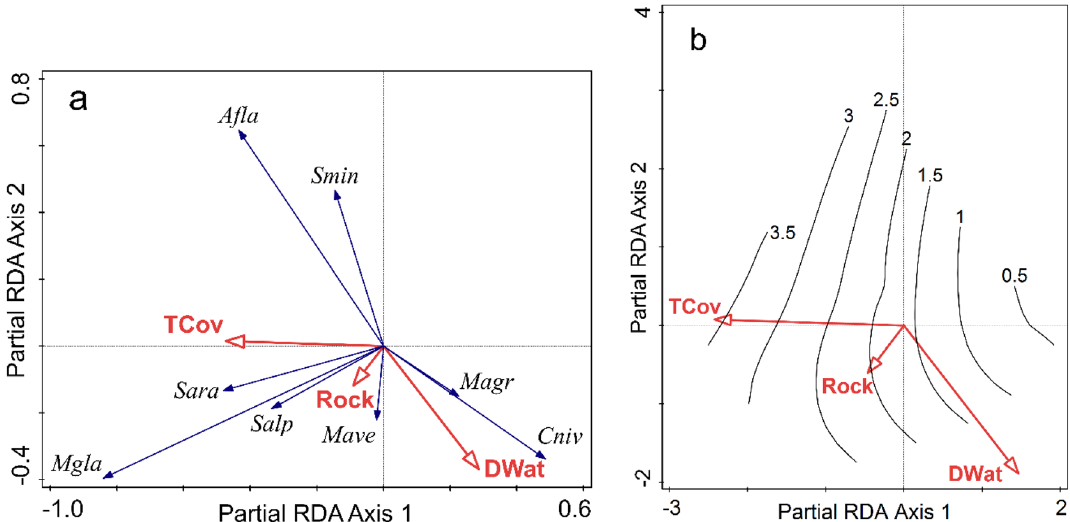
Figure 2. ( a ) Species—habitat biplot diagram from partial RDA (year included as covariate) summarising the effect of tree cover (TCov), distance to water (DWat) and rocks (Rock) on the community abundance (response data were not standardised by site). The codes for species are given by the initial of genus and first three letters of species name. The length of the arrows representing the predictors is given by the strength of their correlation with the first two ordination axes (indicated by the projection of the arrows on the two axes). The angle between arrows indicates the correlation between individual variables. The angle between species arrows indicates the correlation between the capture index of species (positive when the angle is sharp). The length of the arrow is a measure of fit for the species. ( b ) contour plot of species richness within the ordination space of the first two axes of partial RDA, based on a fitted loess